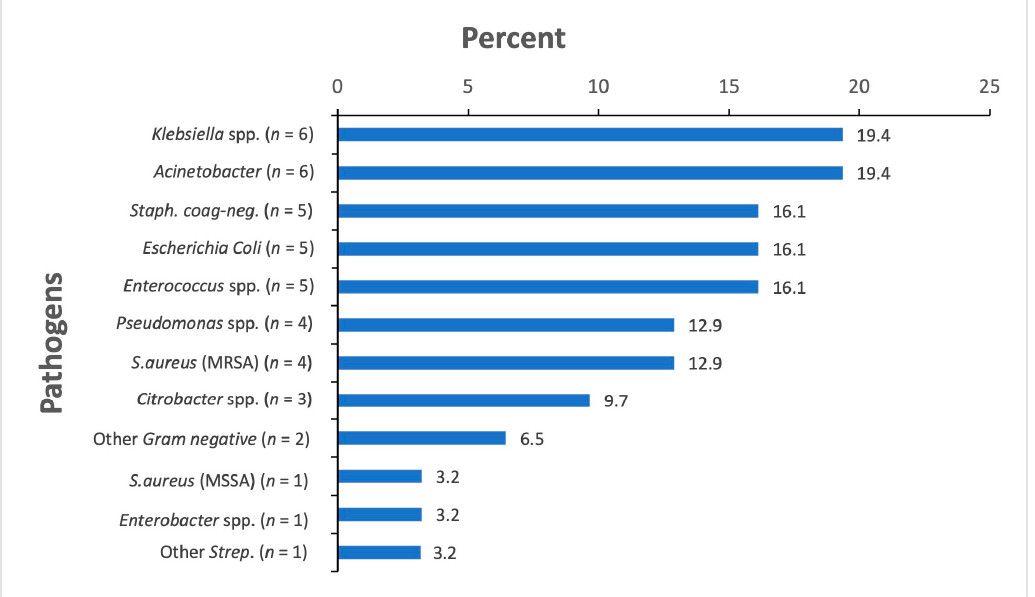
Figure 2. The bacteria isolated in blood cultures, n = 31. Figure legend: n denotes the number of patients with a positive blood culture for bacterial